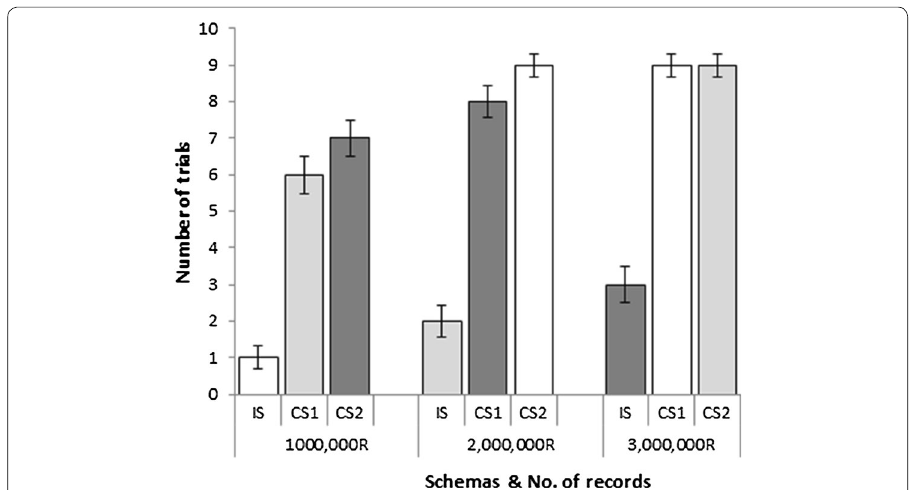
Fig. 4 Hacking using NoSQL‑injection method; success and failure counts for IS, CS1 and